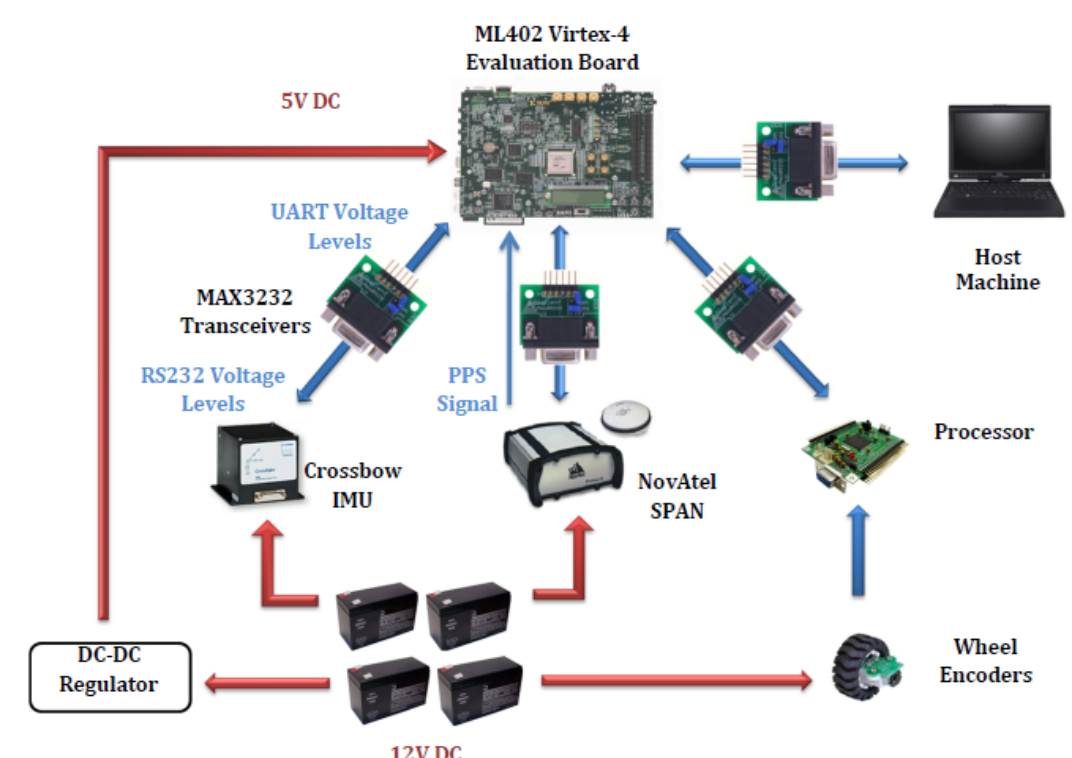
Figure 10. Mobile Robot Equipment Wiring